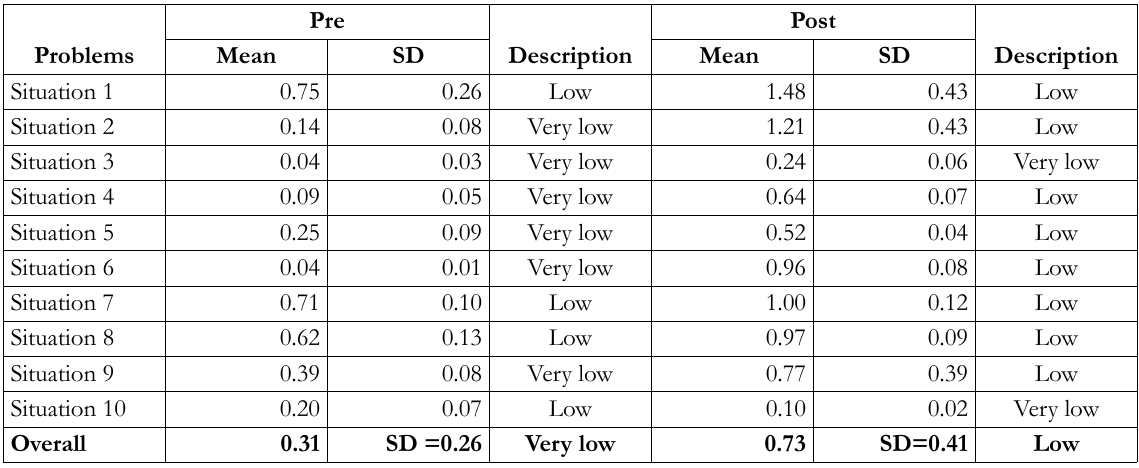
Table 6. The Level of Problem Solving Skills of the PBL Group in the Items of the Problem Solving Skill Test The level of problem solving skills of students under the PBL group before and after they were taught using the PBL approach is presented in Table 7.